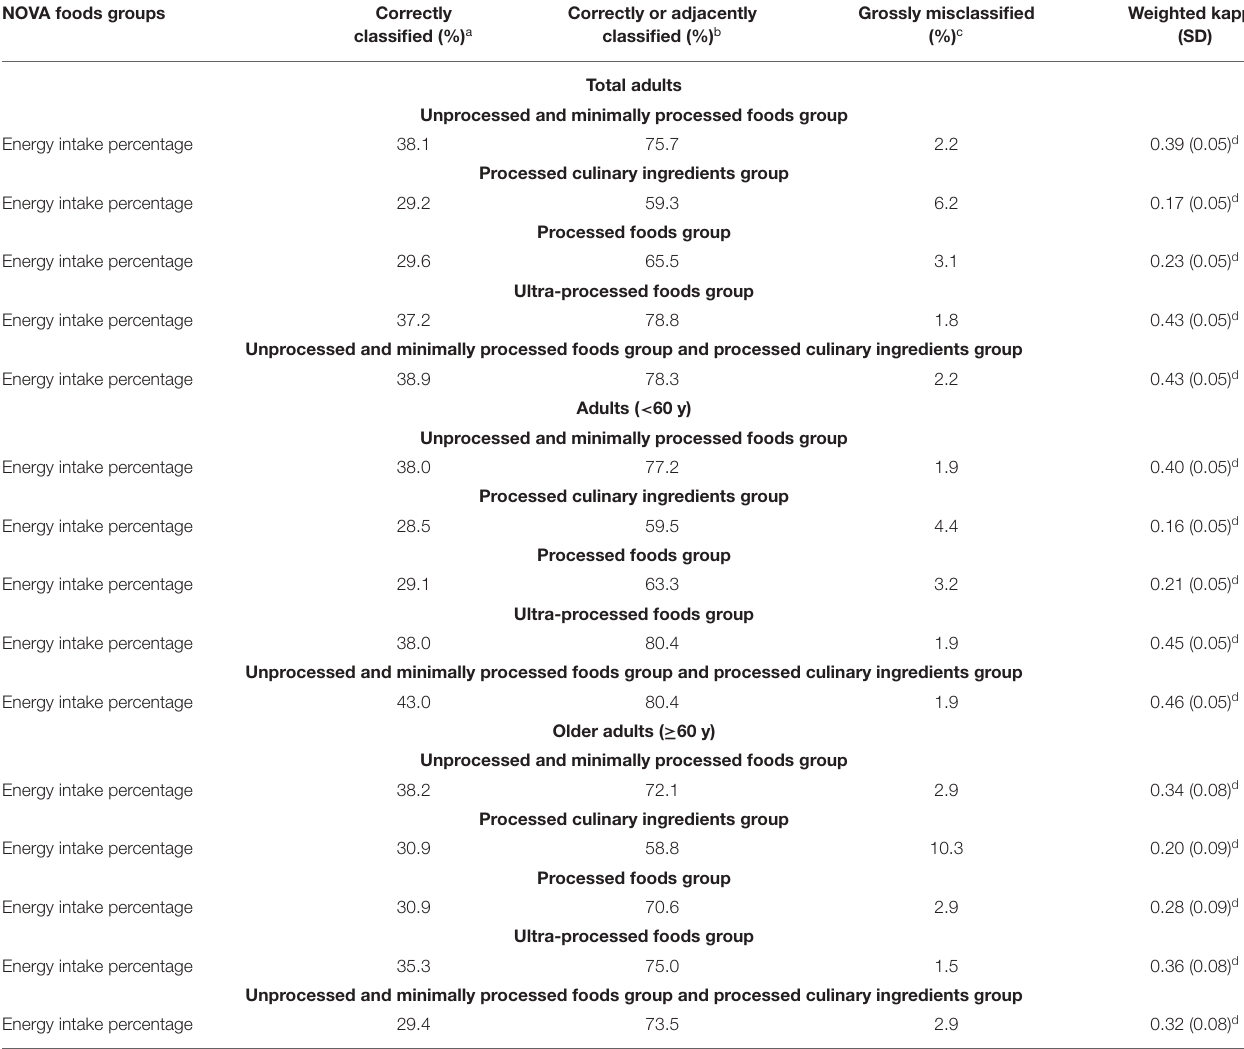
TABLE 4 | Cross classification by quintiles of energy consumption between SFFQ and 24DRs in NOVA foods groups. NOVA foods